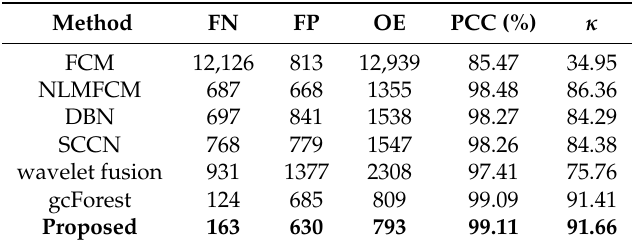
Table 2. Values of the evaluation criteria of the Farmland C data